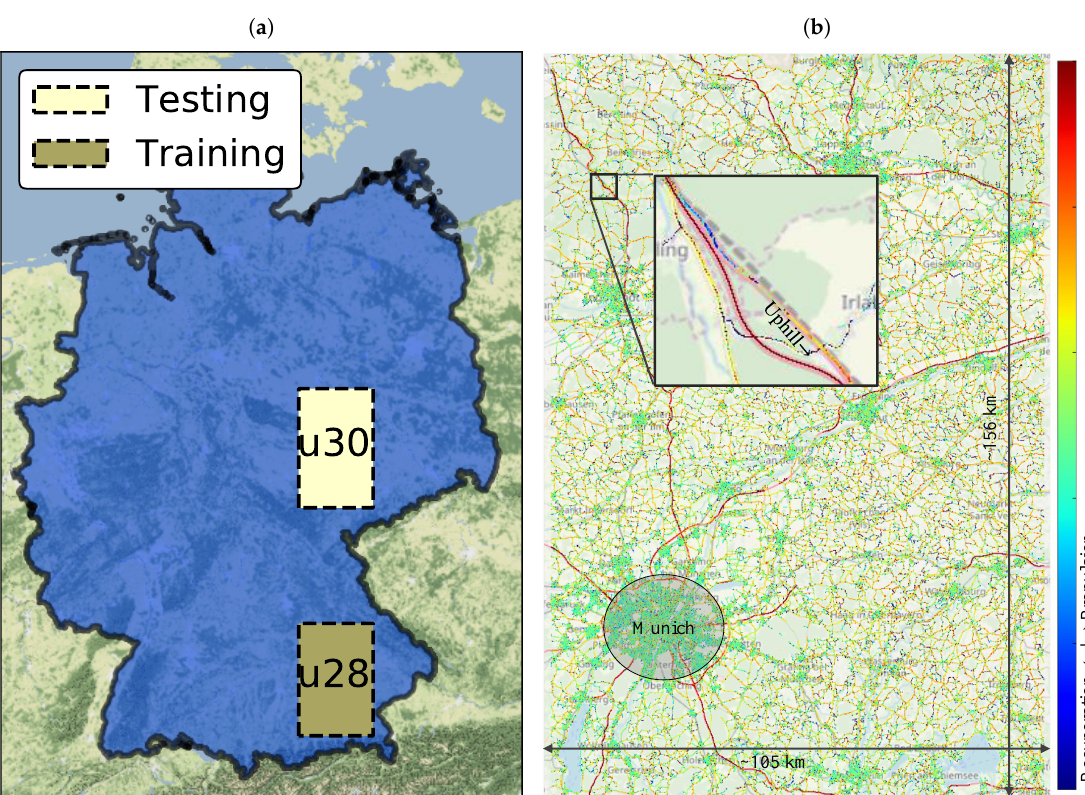
Figure 4. ( a ) Map of the two origin regions, where the data are recorded. The records from the region u28 serve as training data set. The records of u30 serve as cross-validation data set. ( b ) Energetic Map created using the u28 training data, indicating low (blue) to high (red) energy consumption and also energy recuperation (dark